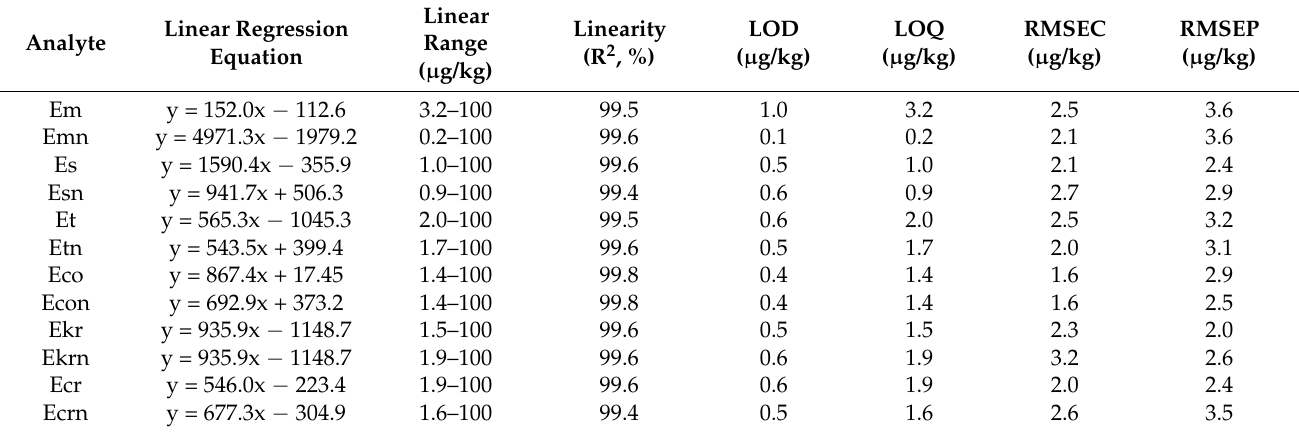
Table 1. Statistical and performance characteristics of the proposed method for the determination of main EAs and their epimers in oat flake samples.